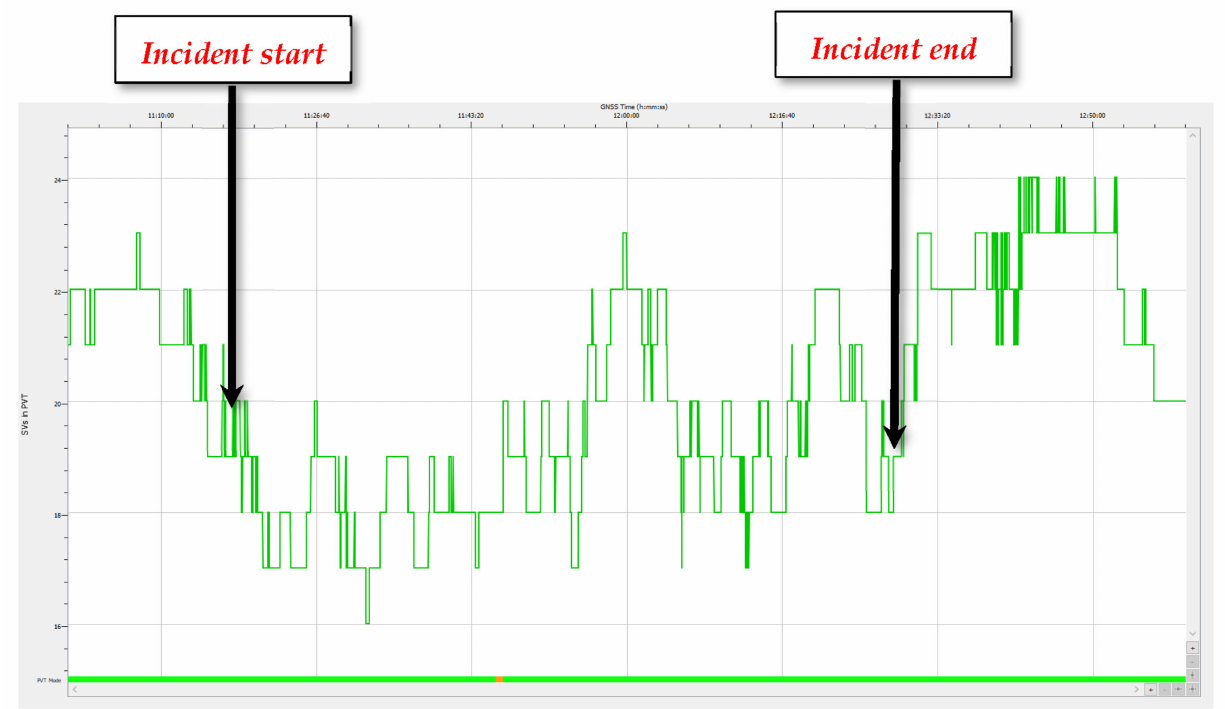
Figure 17. Number of satellites in the monitor station solution during the period 11:00–13:00 GPS time of the Case 1